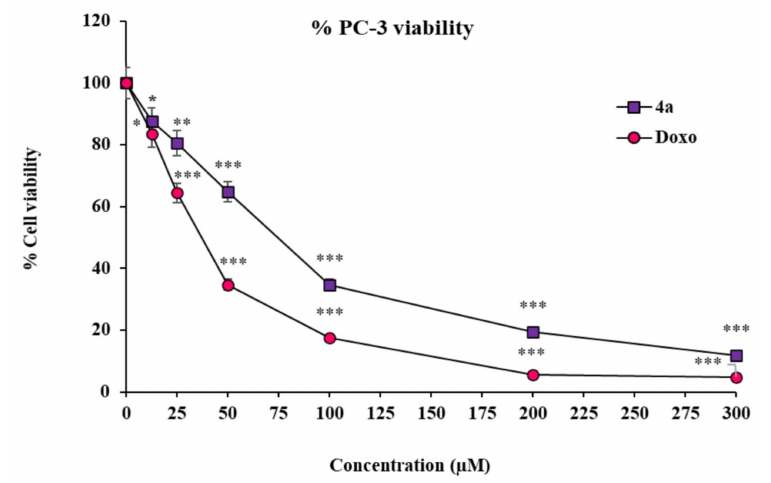
Figure 6. Cytotoxicity of 4a and doxorubicin against PC-3 cells. Values (percent cell viability) are mean ± SEM from triplicate measurements. Significantly different from untreated PC-3 cells at *** p < 0.001; ** p < 0.01; and * p < 0.05. The statistical analysis (ANOVA) was performed using GraphPad Prism Software version 9.5.0., San Diego, CA, USA.